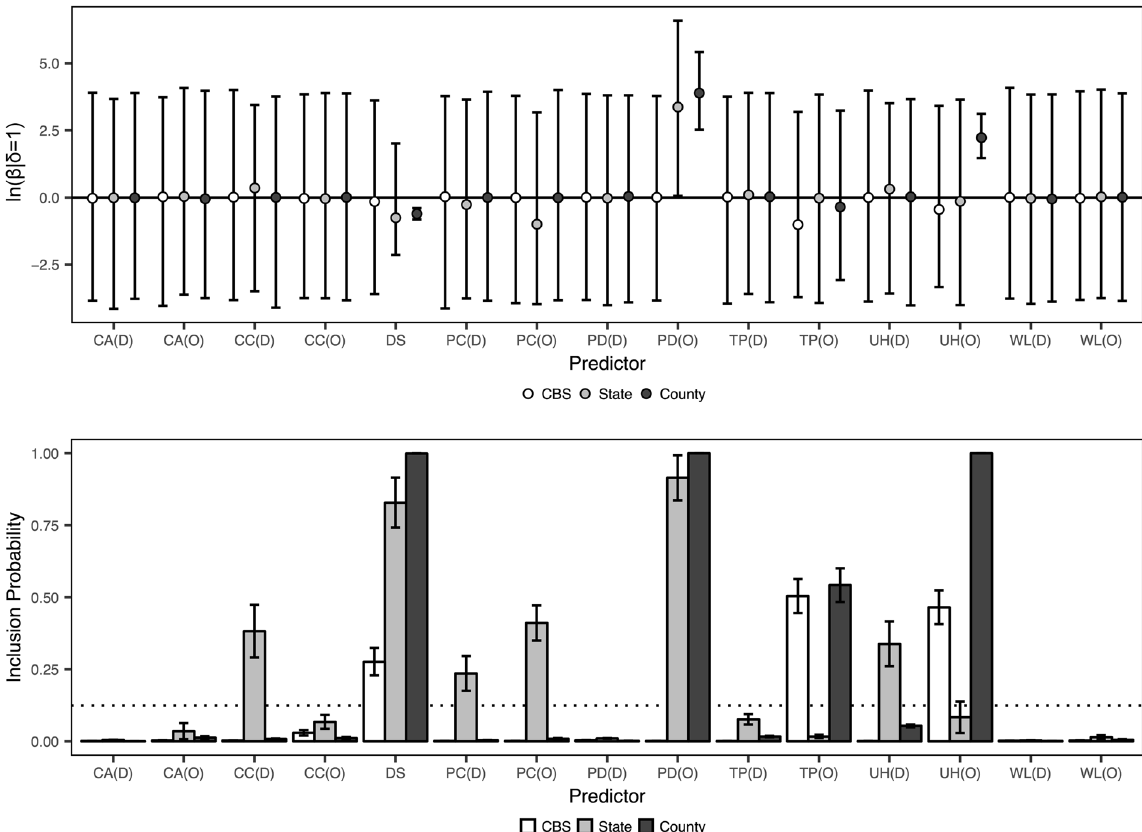
Figure 1. Posterior metrics for the predictors in the three national models. Inclusion probabilities for the predictor indicators ( δ ) and corresponding regression coefficients ( β ) for the 15 predictors for the CBS, state, and county aggregations. The dotted line corresponds to BF = 3. Error bars represent the standard error for each predictor’s inclusion probability and the 95% HPD for each predictor’s regression coefficient. Predictors are annotated with their evaluation from location of origin (O) and location of destination